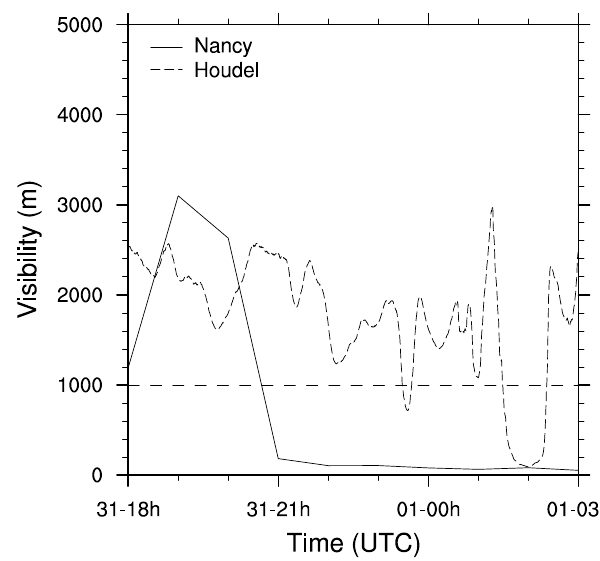
Figure 2. Visibility observed at 2 m at Nancy (solid line) and at 10 m at Houdel (dashed